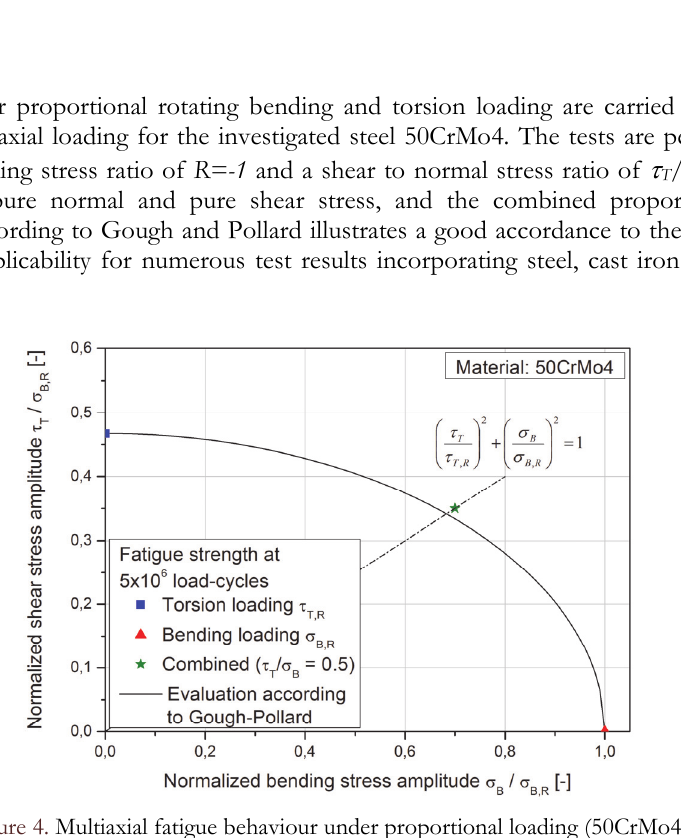
Figure 4. Multiaxial fatigue behaviour under proportional loading (50CrMo4).